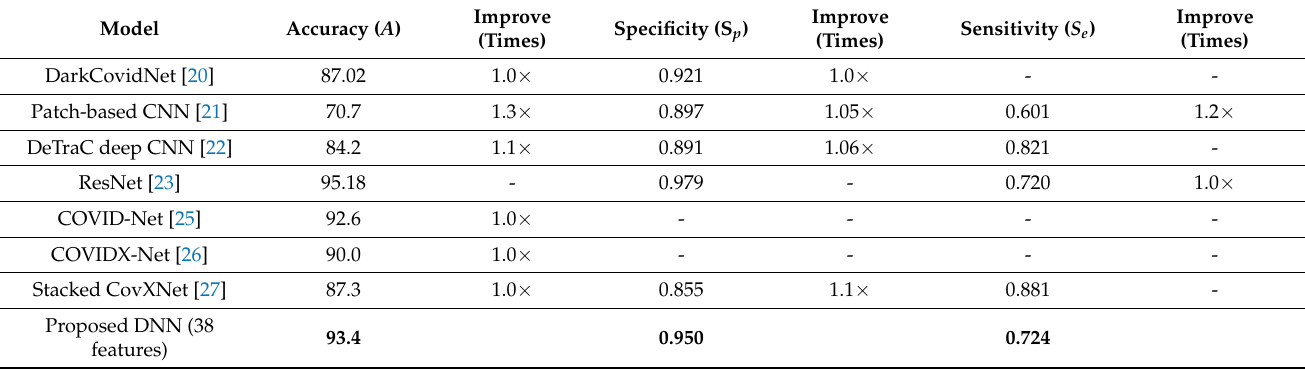
Table 7. Comparison of the proposed model with existing